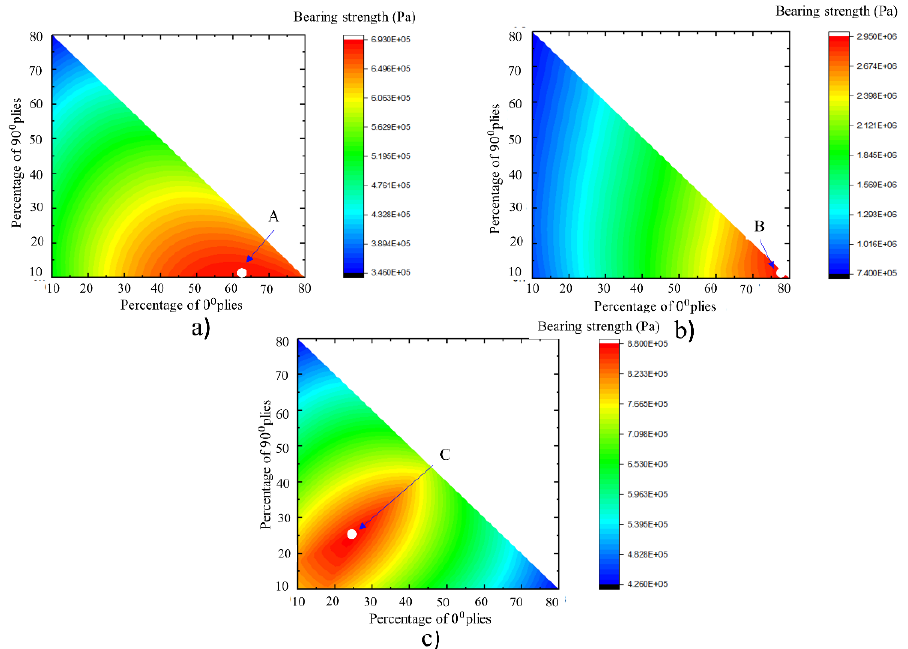
Figure 7. Carpet plots for load-bearing capacity ( a ) Open-hole laminate under uniaxial loadings ( b ) Filled-hole laminate under uniaxial loadings ( c ) Open-hole laminate under multiaxial loading .